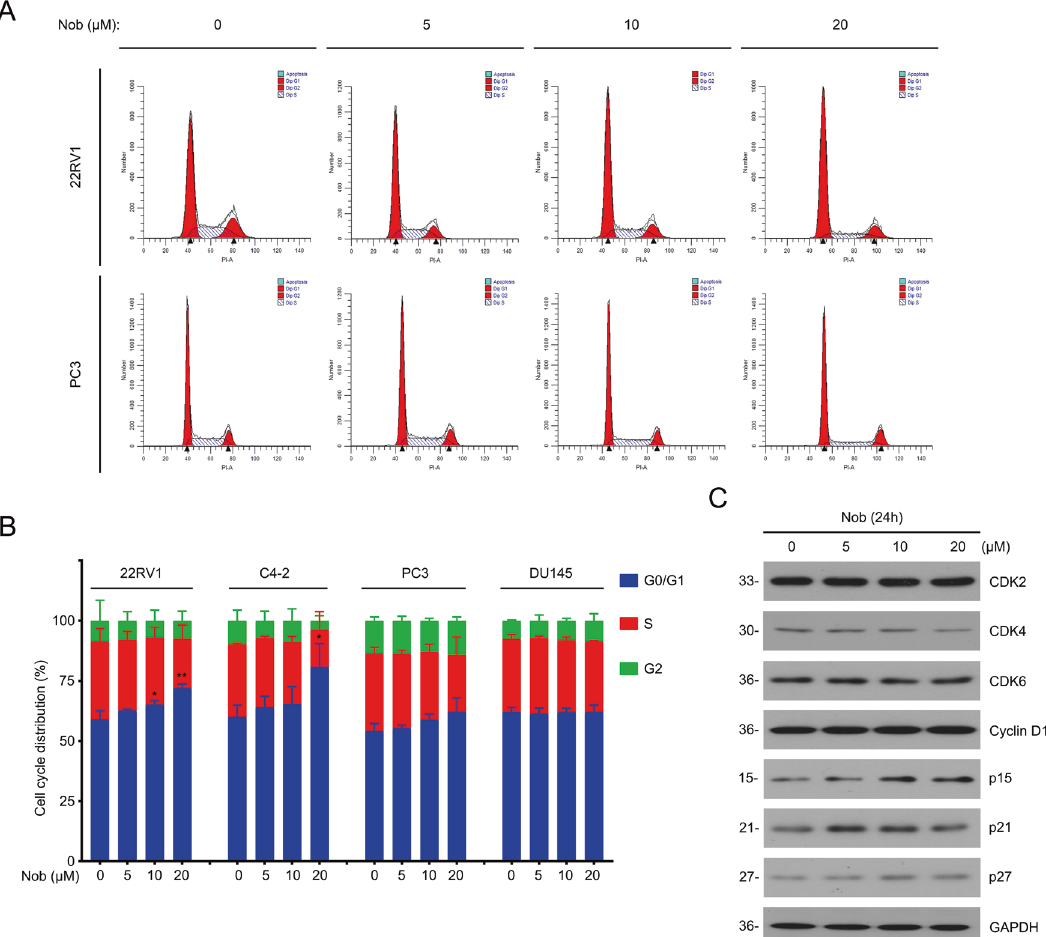
independent experiments. C Western blot analysis of indicated proteins in 22Rv1 cells treated with nobiletin for 24